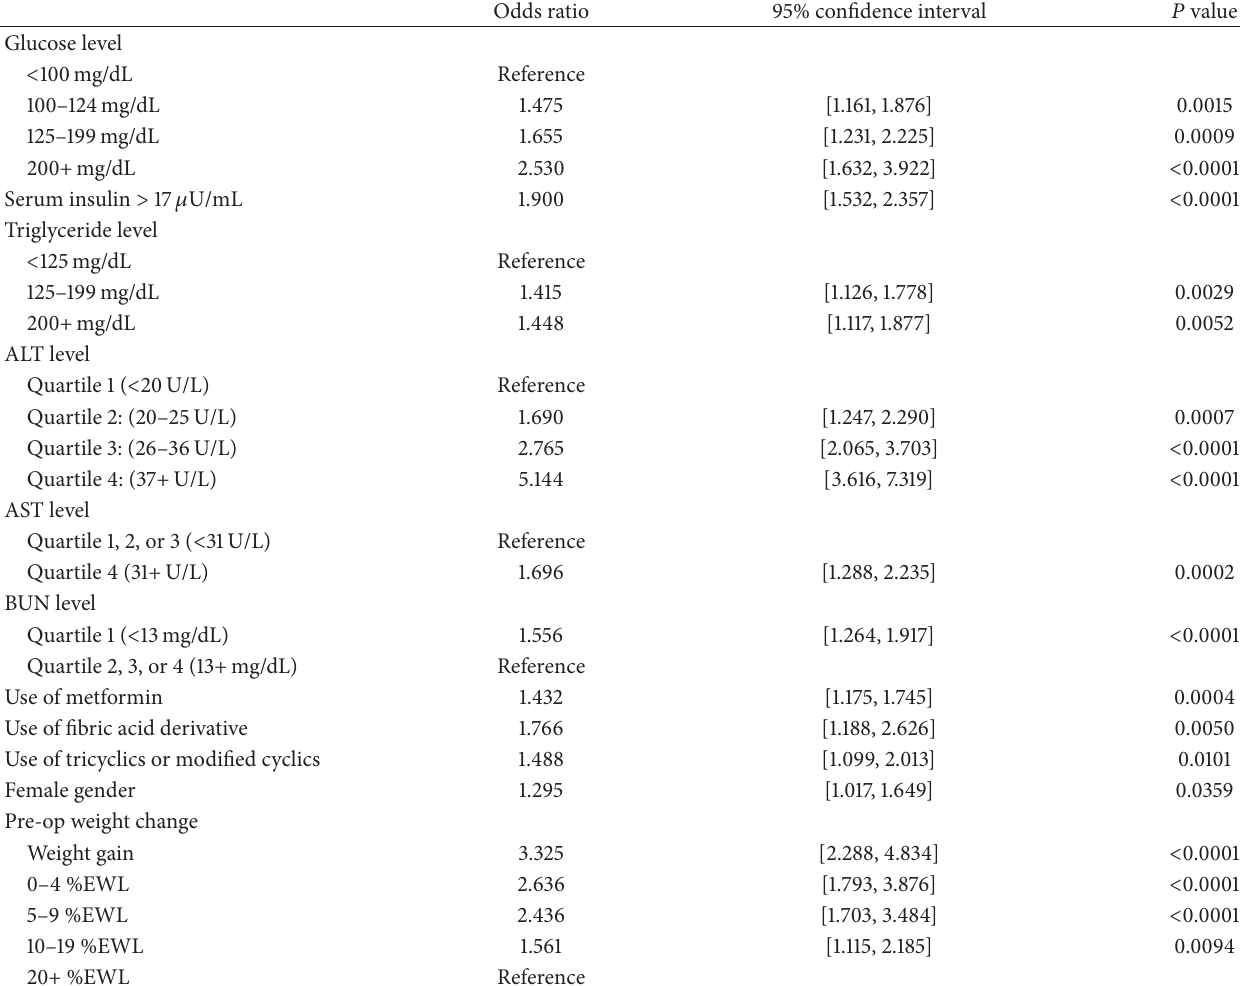
Table 3: Multiple regression results for severity of hepatic fat (grades 2 and 3 versus grade